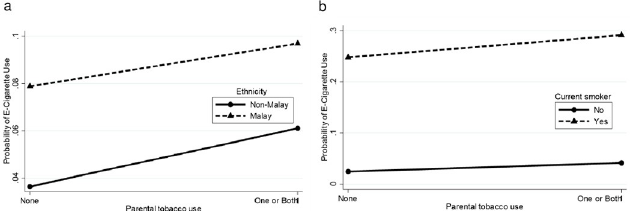
Fig 7. Probability of current e-cigarette use. (a) Parental tobacco use-ethnicity: one or both parents (non- Malay = 6.1%, Malay = 9.7%), none (non-Malay = 3.6%, Malay = 7.9%). (b) Parental tobacco use-current smoker: one or both parents (yes = 29.1%, no = 4.1%), none (yes = 24.8%, no =